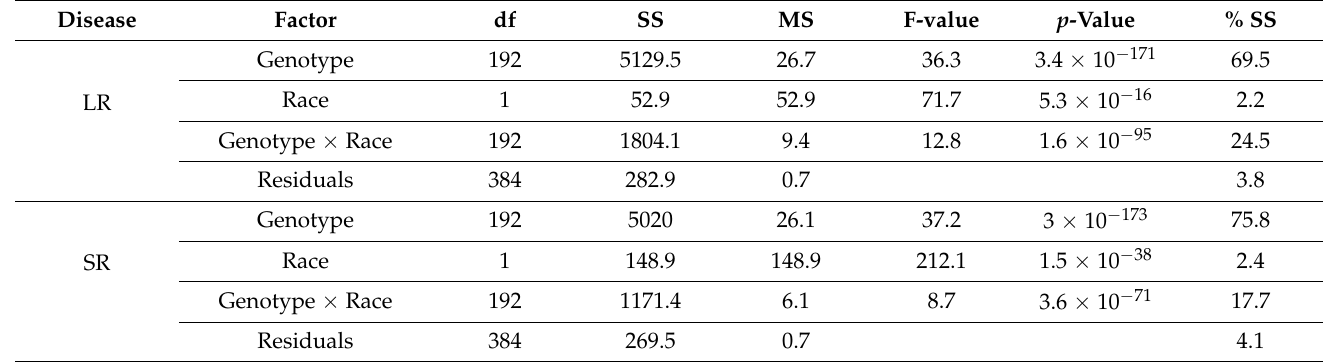
Table 3. Two-way ANOVA of infection type of leaf rust (LR) and stem rust (SR) at the seedling stage. Disease